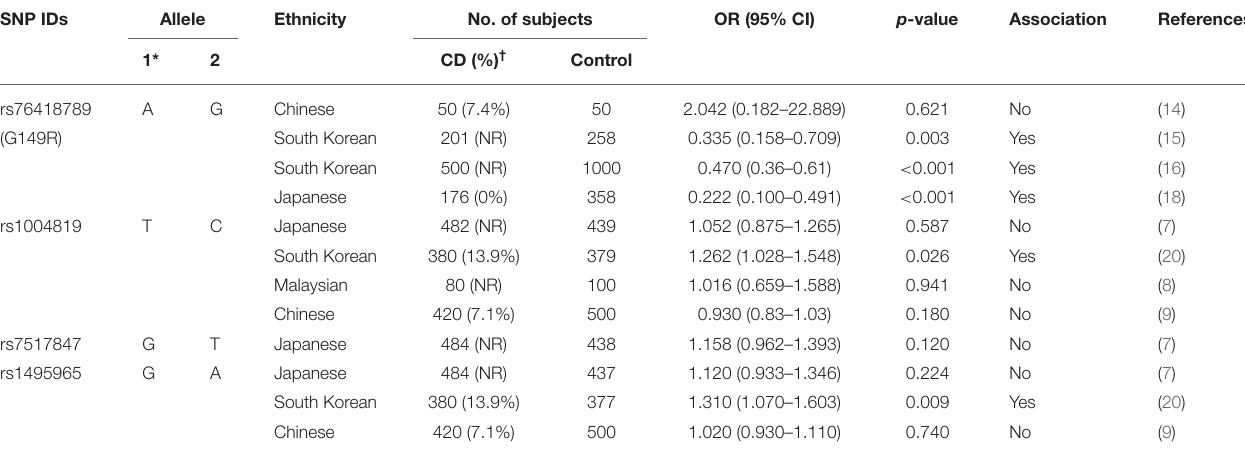
TABLE 6 | Summary of Asian studies for the association of IL23R with Crohn’s disease (CD) susceptibility (7–9, 14–16, 18, 20). SNP